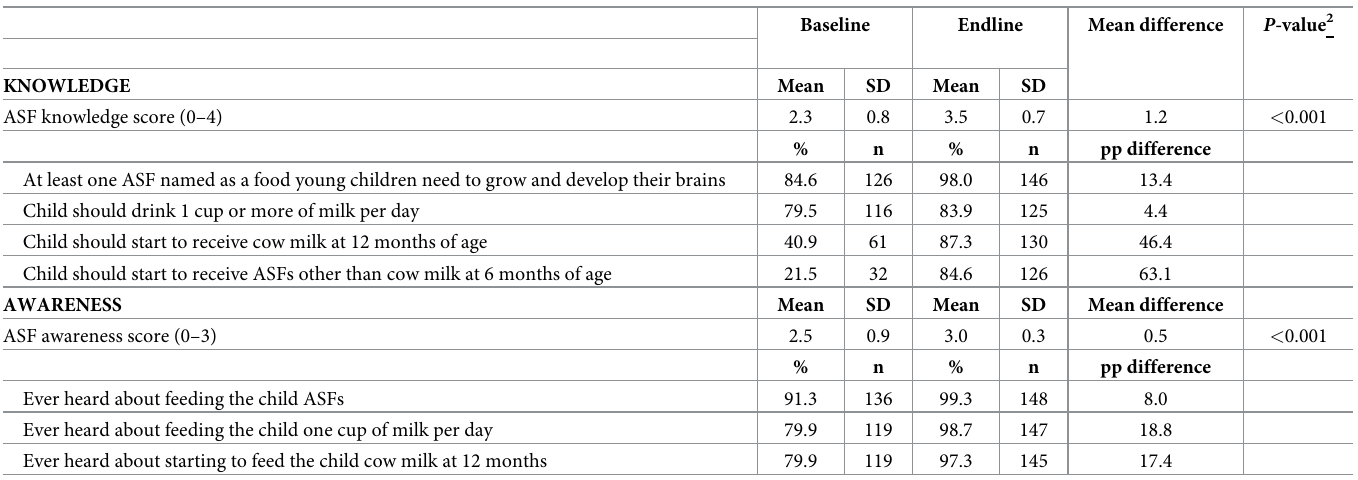
Table 3. Fathers’ knowledge and awareness of ASFs (N = 149) 1